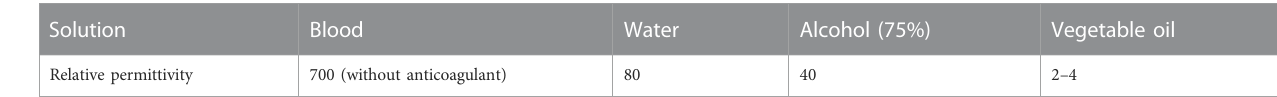
TABLE 2 Relative permittivity of the four solutions (frequency 3